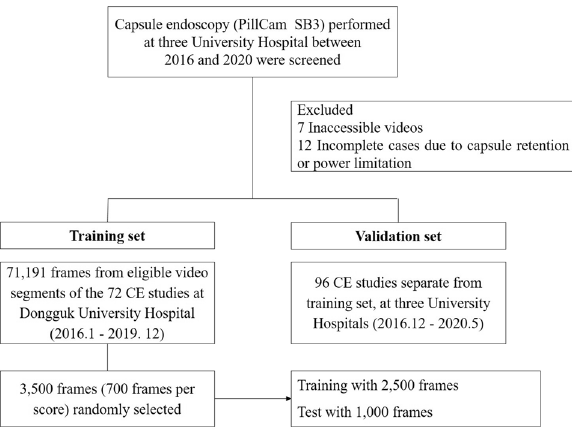
Figure 1. Data flow and deep learning